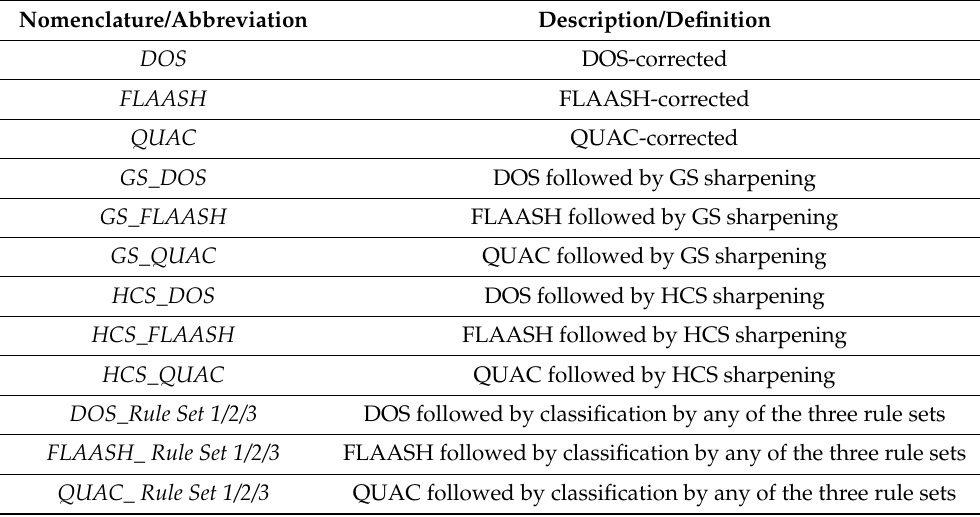
Table 1. Nomenclature of processing schemes and classifications used in the current